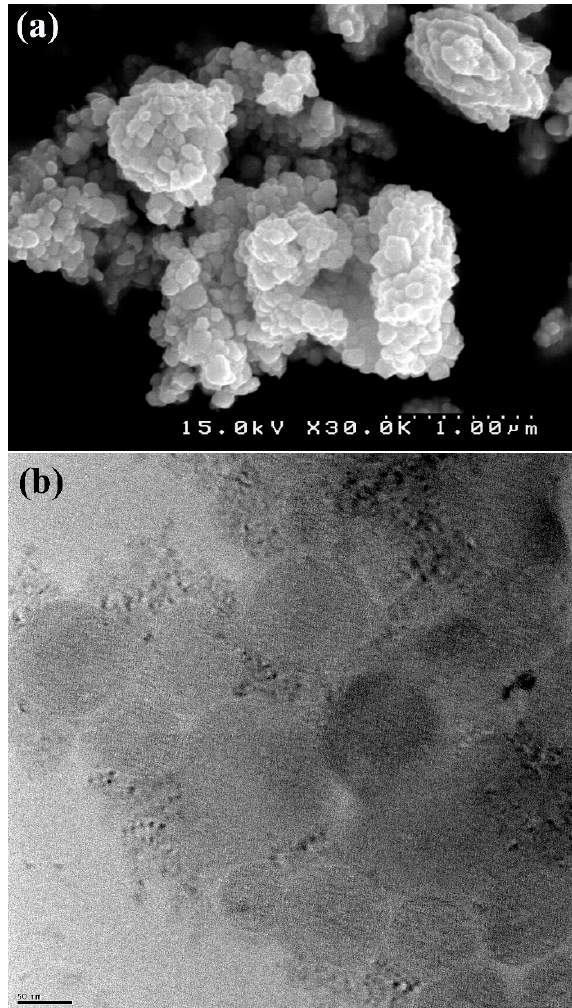
Figure 7. ( a ) SEM and ( b ) TEM images of PbO nano-structures produced by the thermolysis of nano-structures of compound 1 .